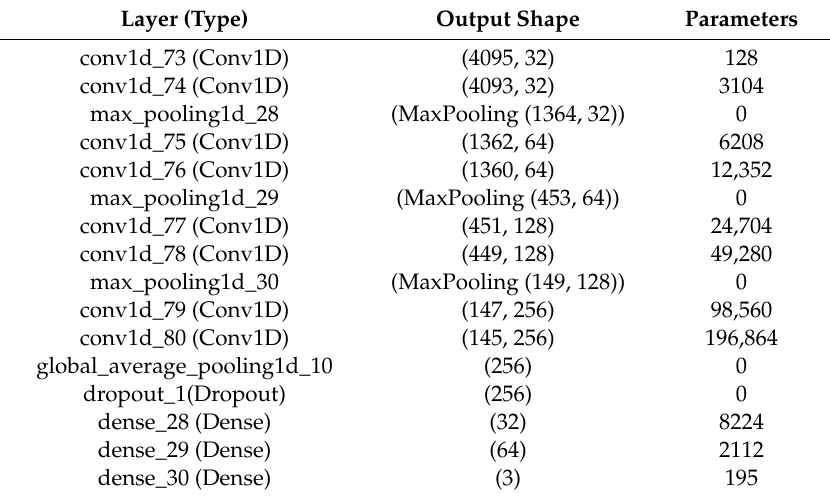
Table 1. Description of the CNN